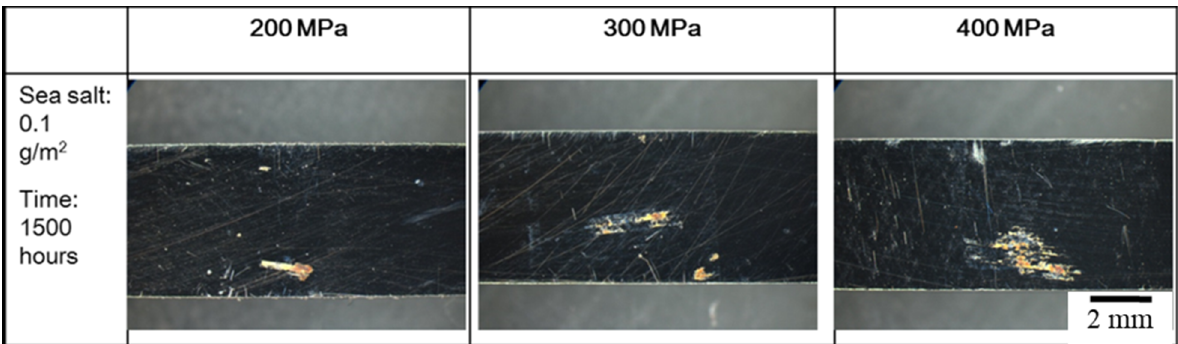
Figure 6. The crevice corrosion specimens with 4 g/m 2 of sea salt deposited on the surface were subjected to tensile stresses of 300 MPa and 400 MPa at a temperature of 45 °C.